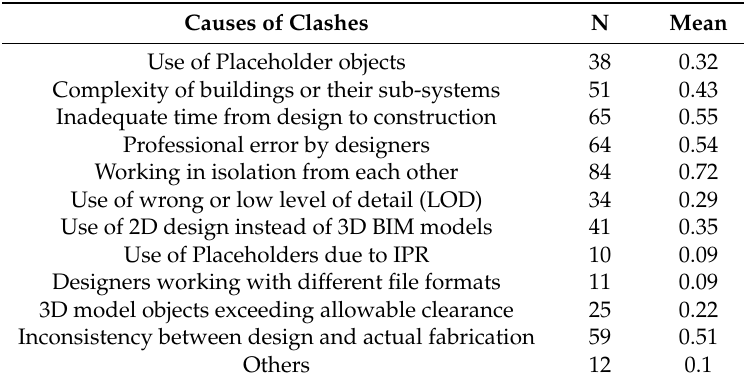
Table 4. Absolute and mean number of causes of clashes according to respondents.